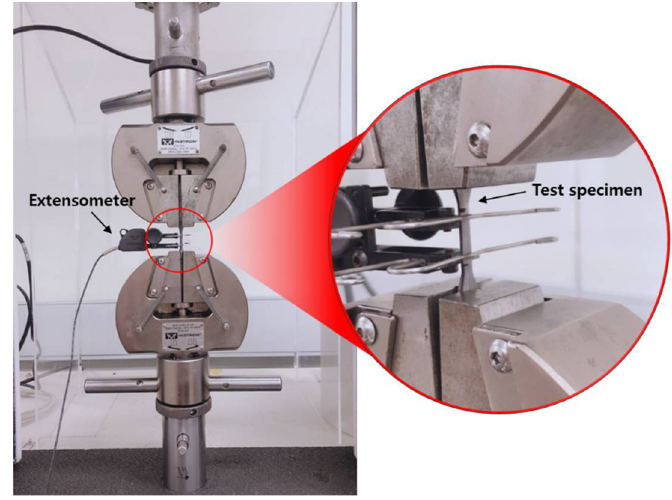
Figure 4. Tensile tests performed to evaluate mechanical properties.